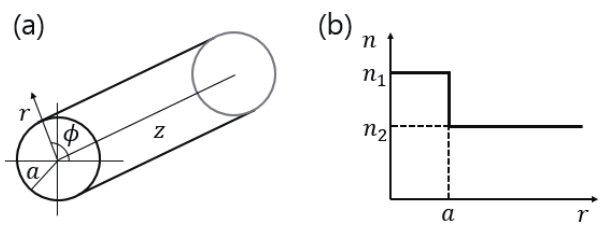
Figure 1. Step-index mathematical model: ( a ) Geometry of an air-clad cylindrical wire. ( b ) Schematic refractive index profile of an air-clad cylindrical wire.